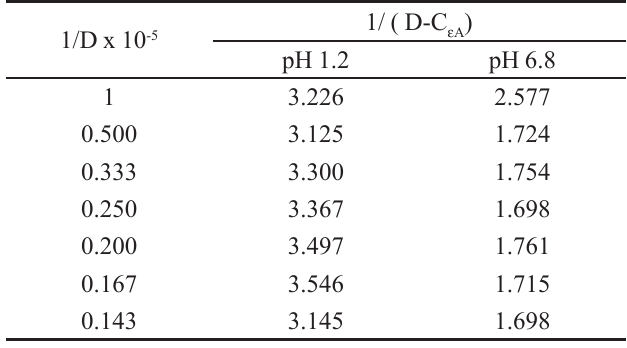
TABLE IV - Absorbance of ketotifen at different pH (using Ardon’s method, when the concentration of ketotifen is constant)